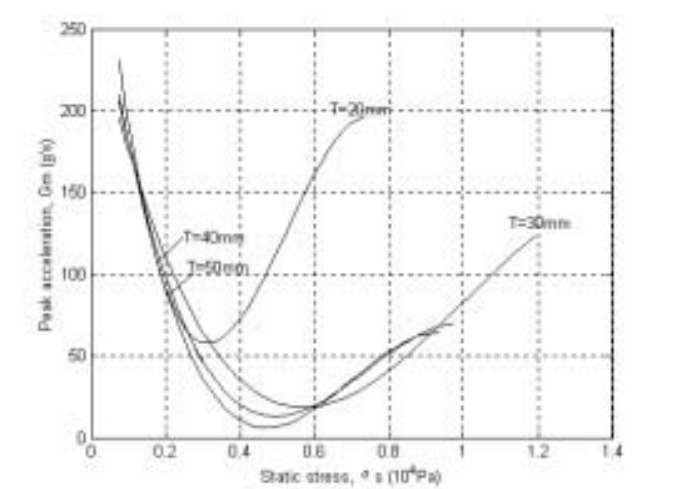
Fig. 10. Dynamic cushion curves of the honeycomb paperboards ( DH = 60